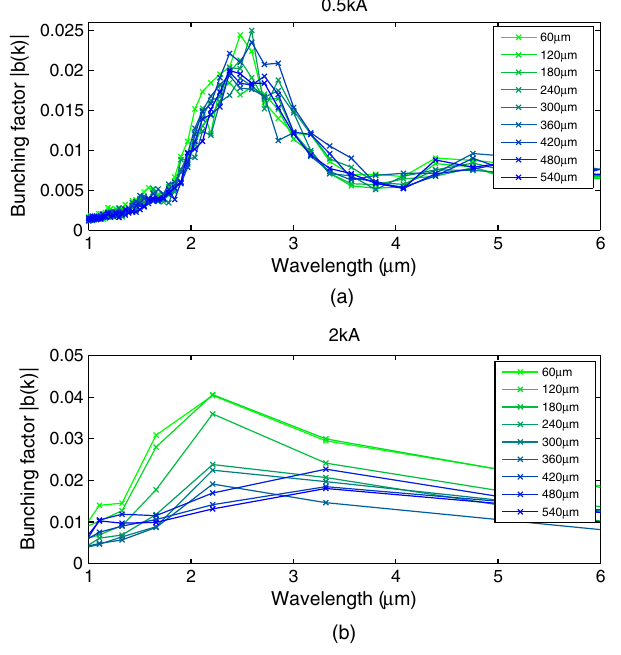
FIG. 14. Bunching factor vs SXRSS chicane strength for peak current and initial energy spread of (a) 0.5 kA and (b) 2 kA. The chicane has negligible effect at 0.5 kA, and weak effect at 2 kA. Data taken with energy spread of 15 keV induced by the laser heater.